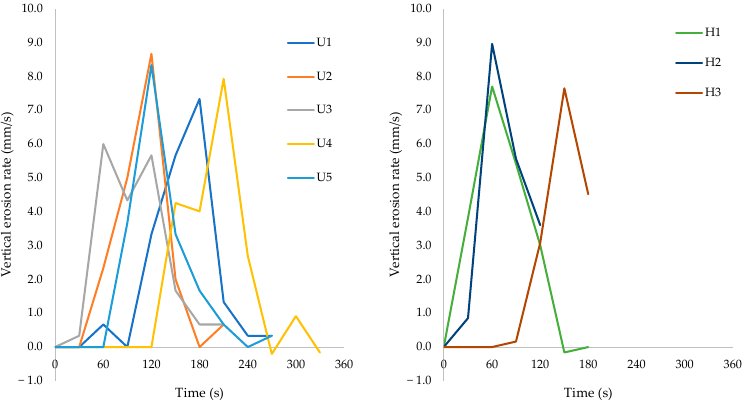
Figure 11. Vertical breach erosion rate E v at X = 0 m from traced side-view pro fi les (mm/s).